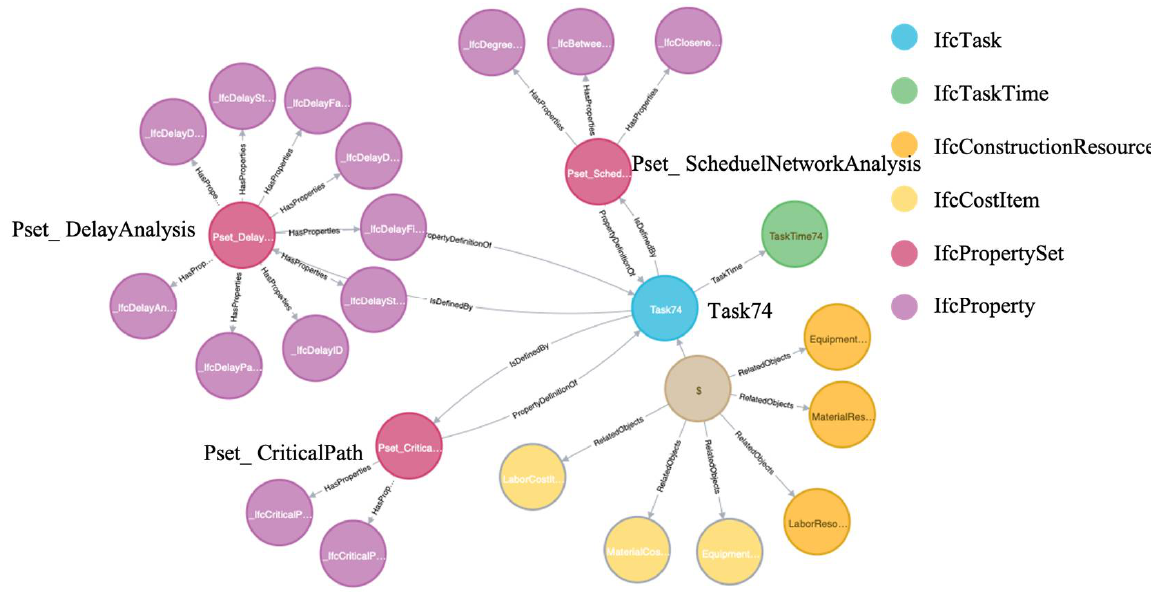
Figure 11. Task74 with corresponding information.